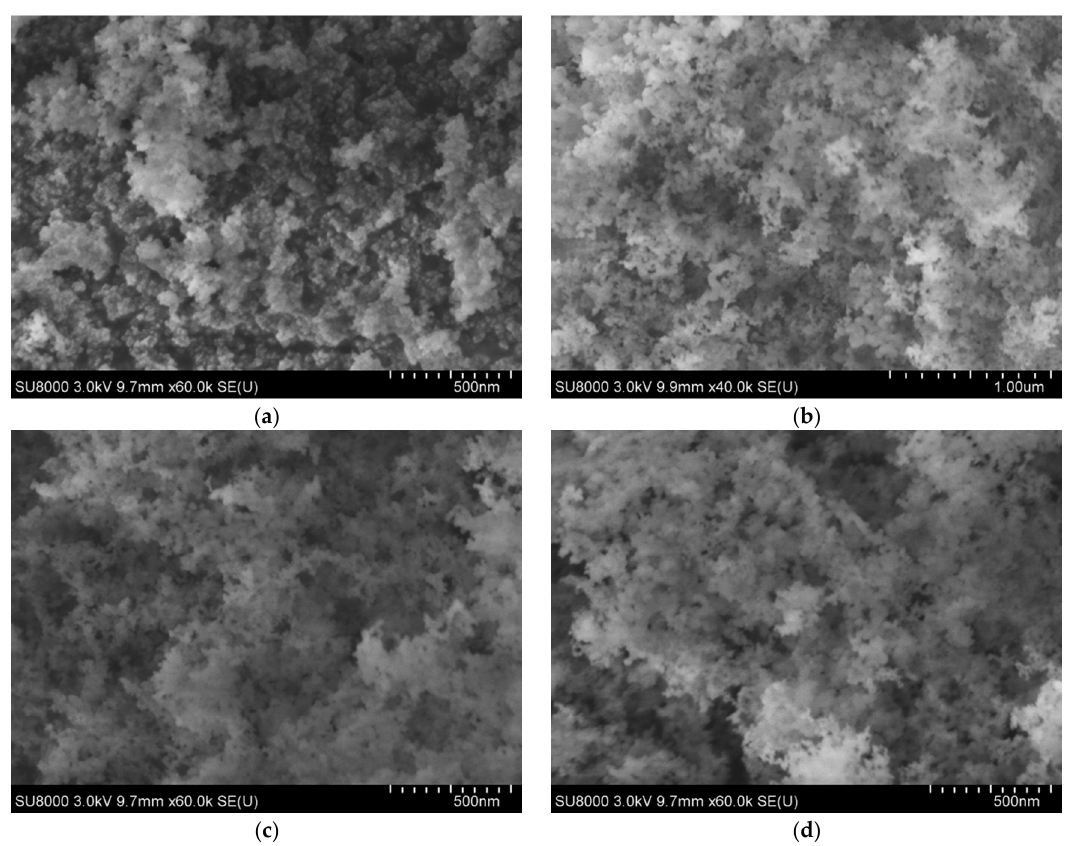
Figure 3. SEM images of nanosilica and three hydrophobic nanosilica materials at magnifications of × 60,000. ( a ) Silica; ( b ) OCS-Silica; ( c ) SOC-Silica; ( d ) SCA-Silica.